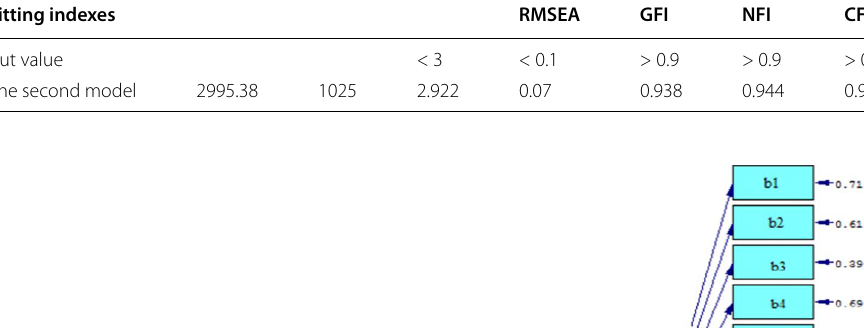
The t -values and standardized estimates were investigated to scan the strengths of the causal relationships among the variables. Figures 2 and 3 show that the influence of AER on CSA ( β 0.67, t 13.33) and AB ( β 0.72, t 16.97) was significantly = = = = positive (the t -value was greater than 1.96). Moreover, the influence of CSA on AB was significant and in a positive direction ( β 0.84, t 20.43), and the t -value was = = greater than 1.96.